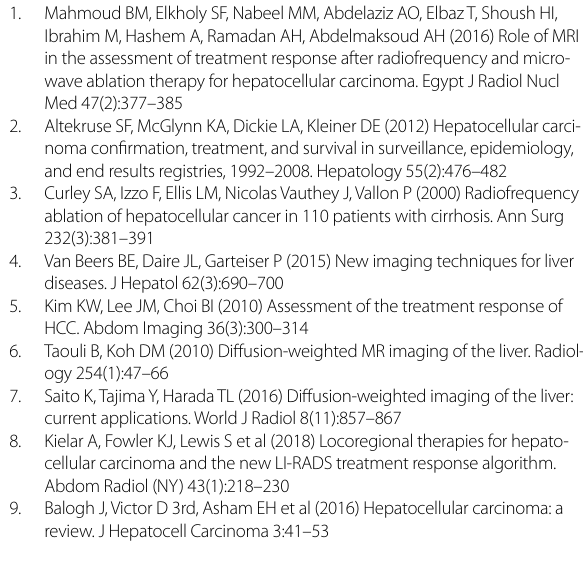
nADC normalized ADC, TP true positive, TN true negative, FP false positive, FN false